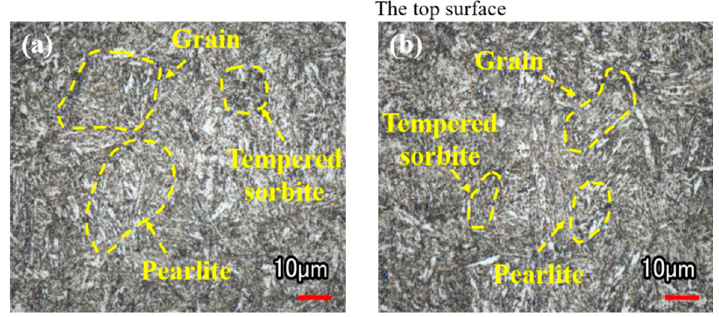
Figure 12. Metallographic structure before and after LSP ( a ) Untreated ( b ) Energy: 10 J.